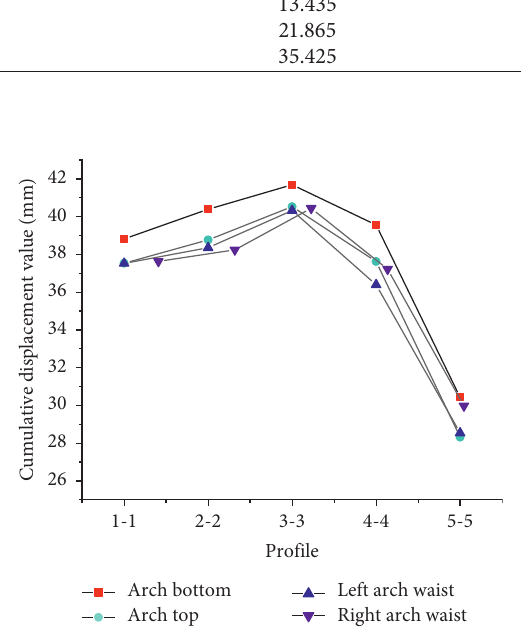
Figure 6: Cumulative displacement values at different measure- ment points in each